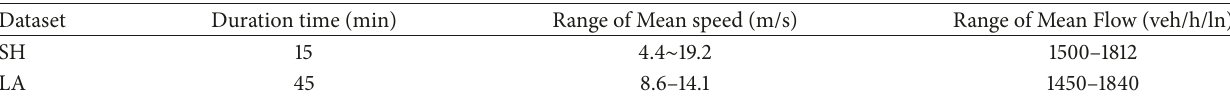
Table 2: Statistics of traffic flow